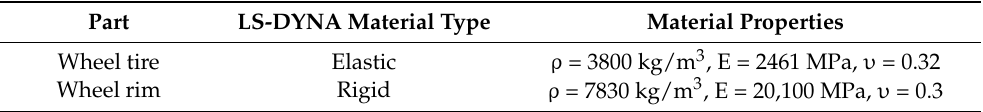
Table 3. Material parameters of the constitutive model of the wheel. Part